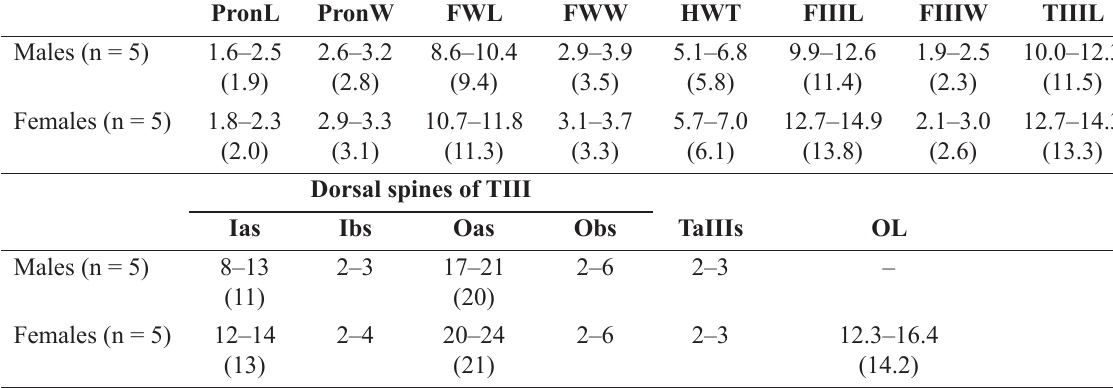
Table 11. Measurements of Nisitrus vittatus (Haan, 1844) in mm, means in